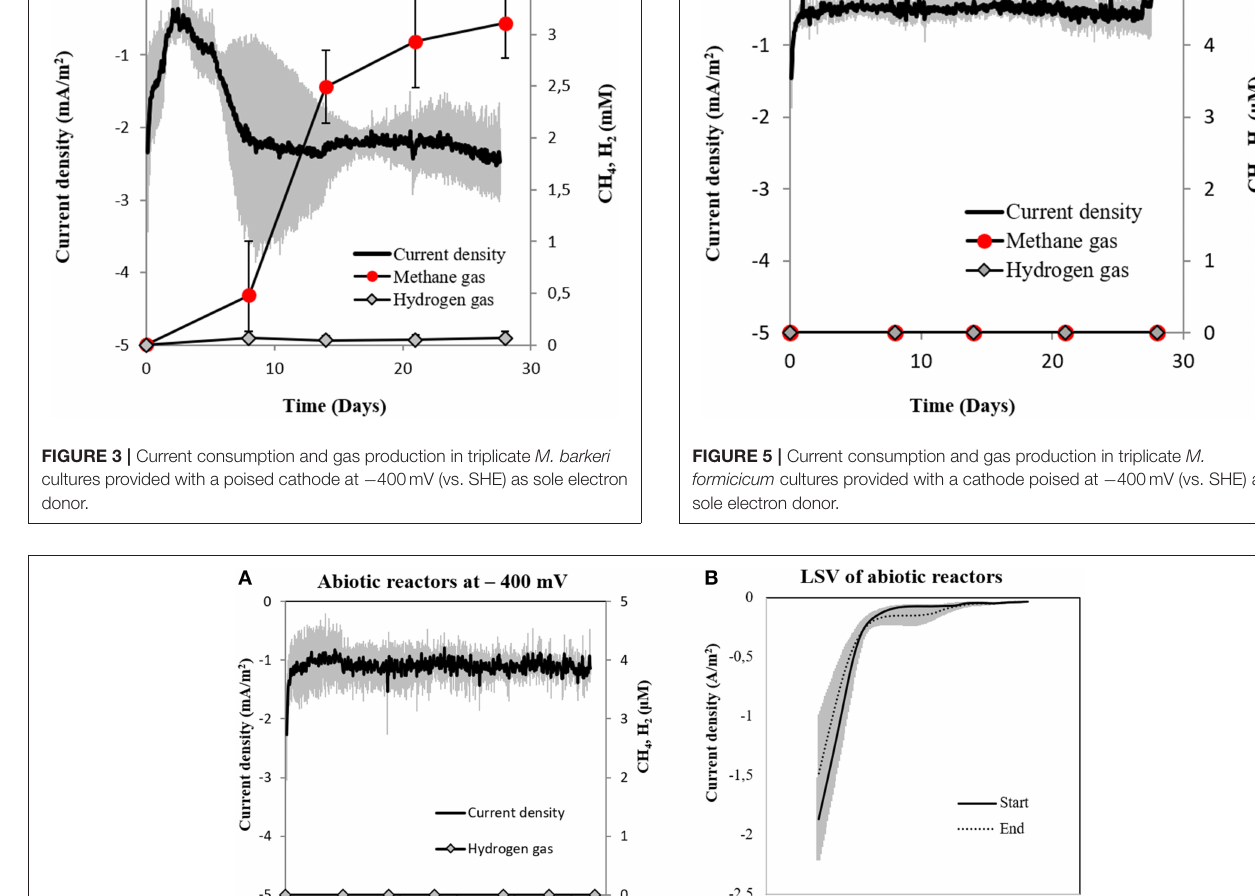
Frontiers in Energy Research |